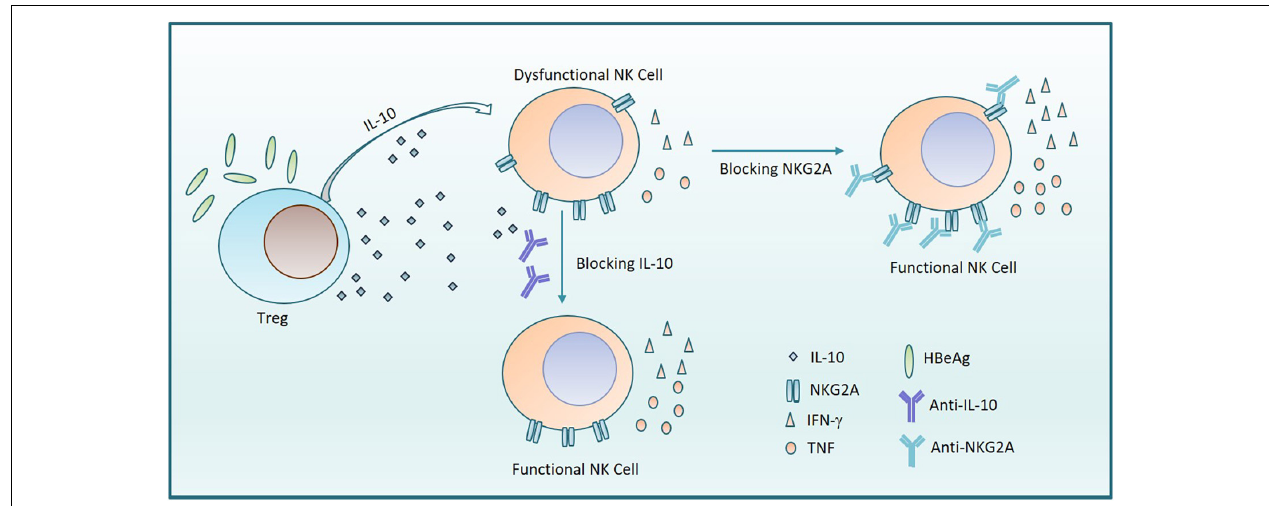
FIGURE 7 | HBeAg induces NKG2A + NK cell dysfunction via Tregs-derived IL-10. The diagram shows that HBeAg induces NK cell dysfunction with upregulated expression of NKG2A on NK cells and reduced secretion of TNF and IFN- γ , which is mediated by increased amounts of IL-10 secreted from Tregs. On the one hand, blocking NKG2A on NK cells leads to the recovery of NK cell function. On the other hand, the function of NK cells is also restored by addition of